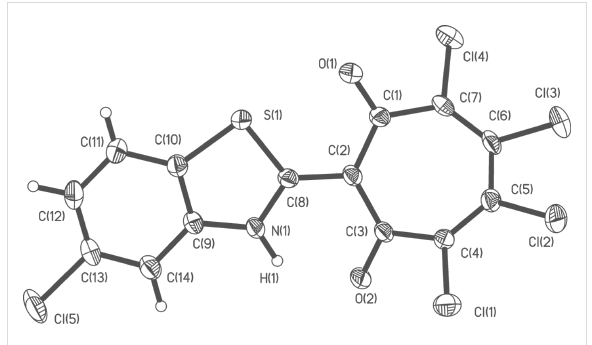
Figure 2: Molecular structure of 2-(5-chlorobenzothiazolyl)-4,5,6,7- tetrachloro-1,3-tropolone 6e . Thermal ellipsoids are drawn on the